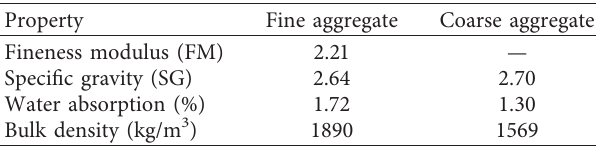
Table 2: Aggregate